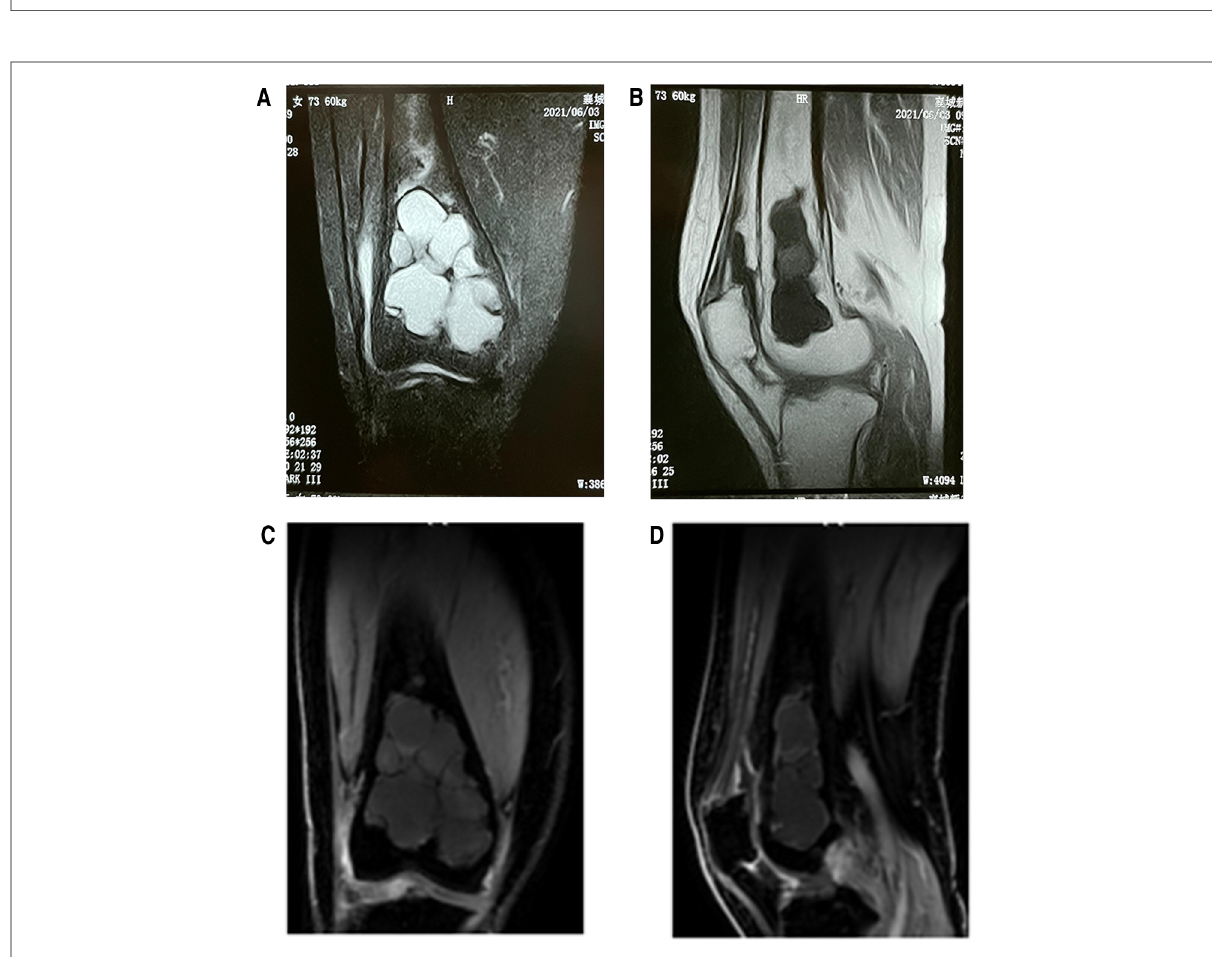
FIGURE 3 ( A ) preoperative frontal MRI indicating multiple cystic abnormal signal shadows in the lower right femur and the surrounding soft tissues had no special changes; ( B ) preoperative sagittal cross-sectional MRI indicating multiple cystic abnormal signal shadows and the surrounding soft tissues had no special changes; ( C ) preoperative frontal contrast-enhanced MRI indicating multiple cystic abnormal signal shadows and the surrounding soft tissues had no special changes; ( D ) preoperative sagittal cross-sectional contrast-enhanced MRI indicating multiple cystic abnormal signal shadows and the surrounding soft tissues had no special